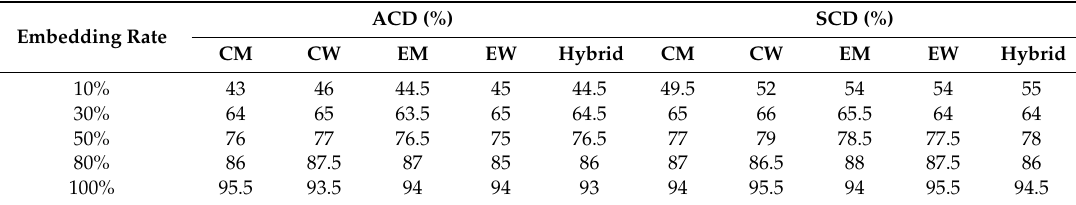
Table 4. Average detection rates for ACD and SCD of di ff erent embedding rates (%). ACD Embedding Rate